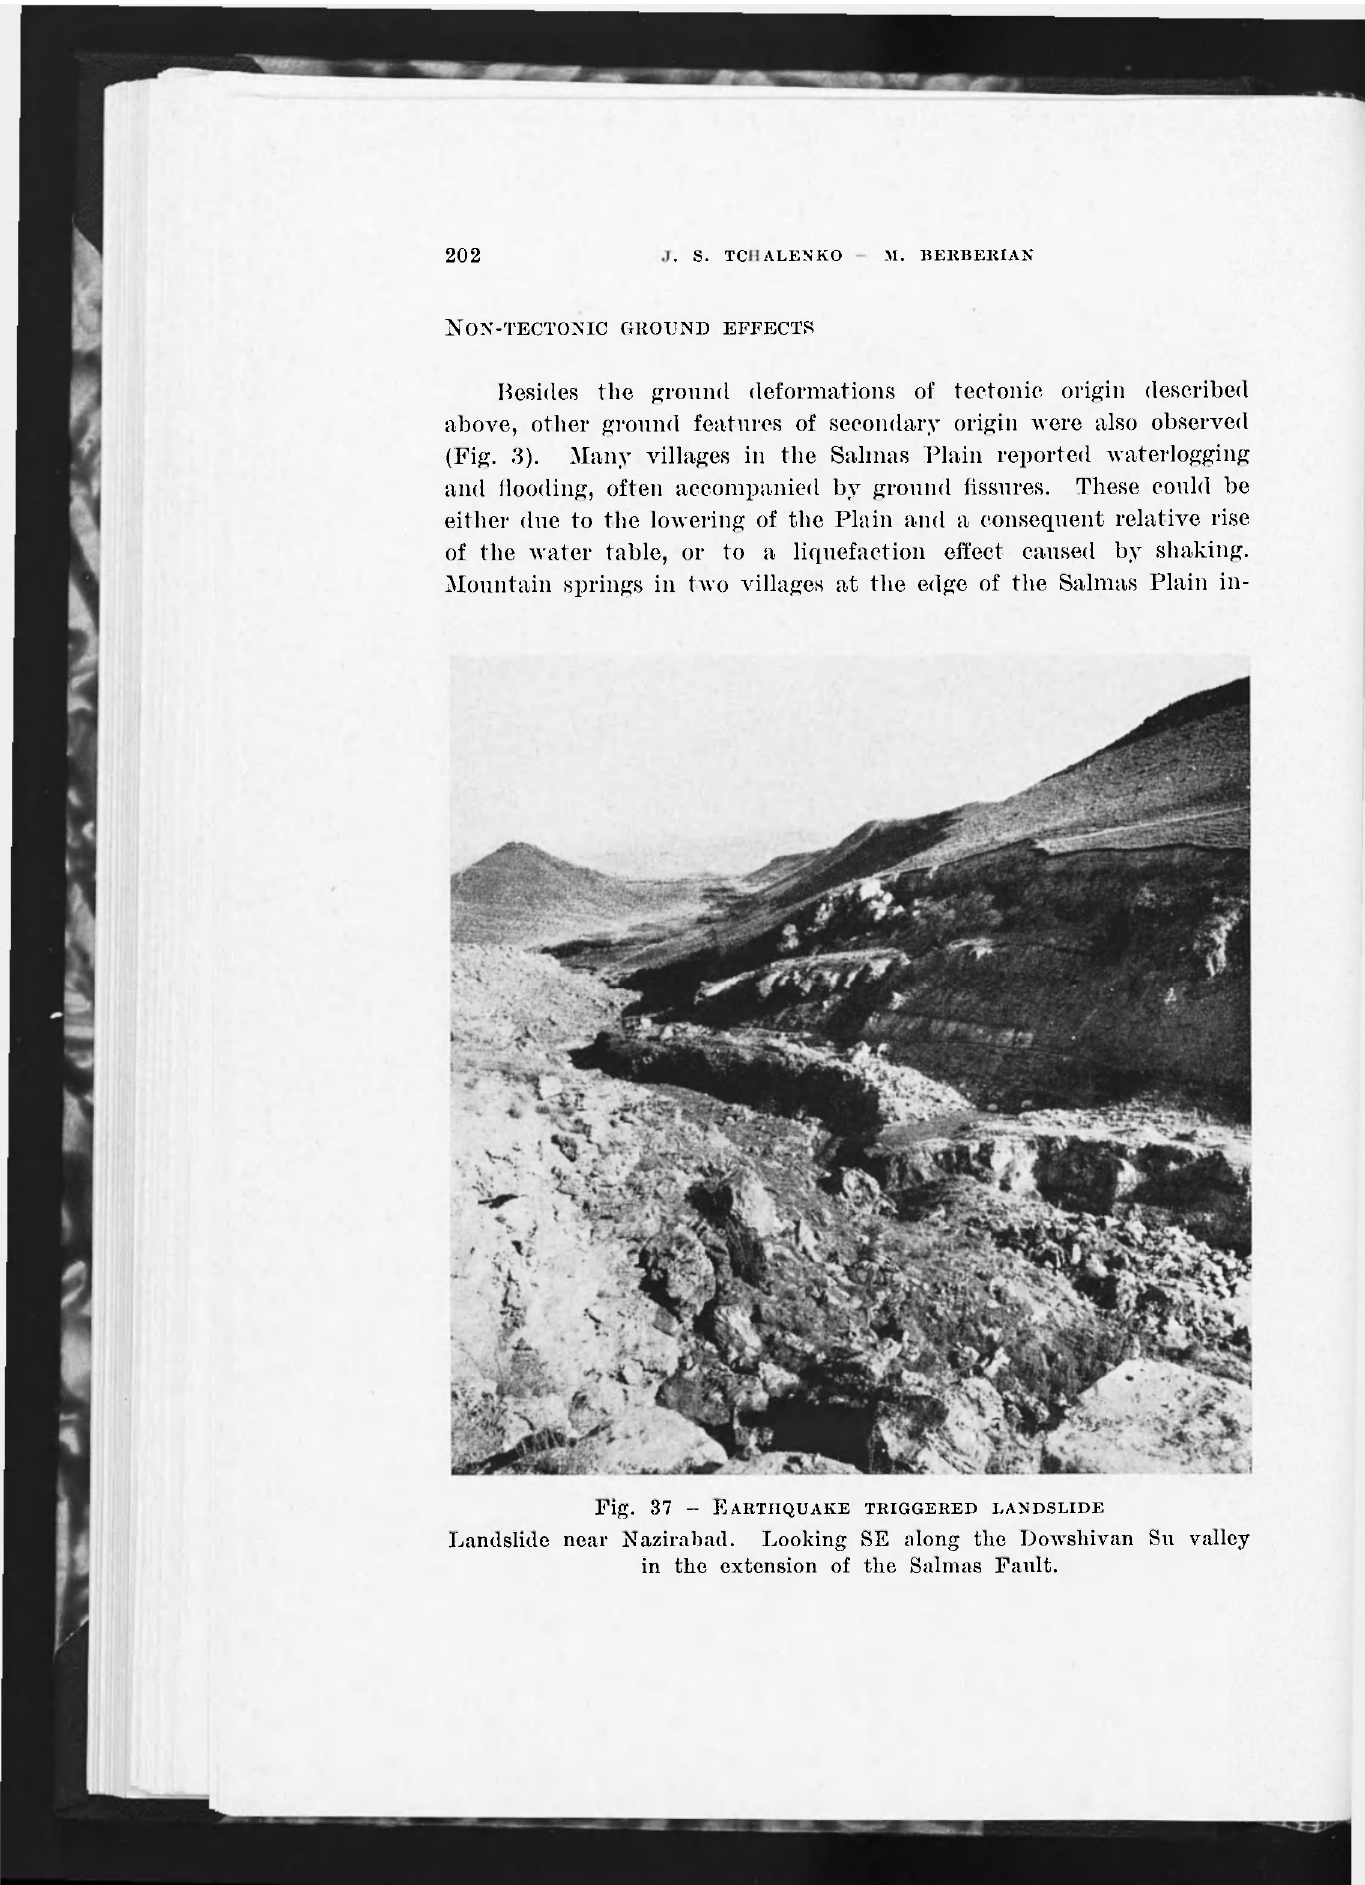
•T. S. TCIIALENKO - M.